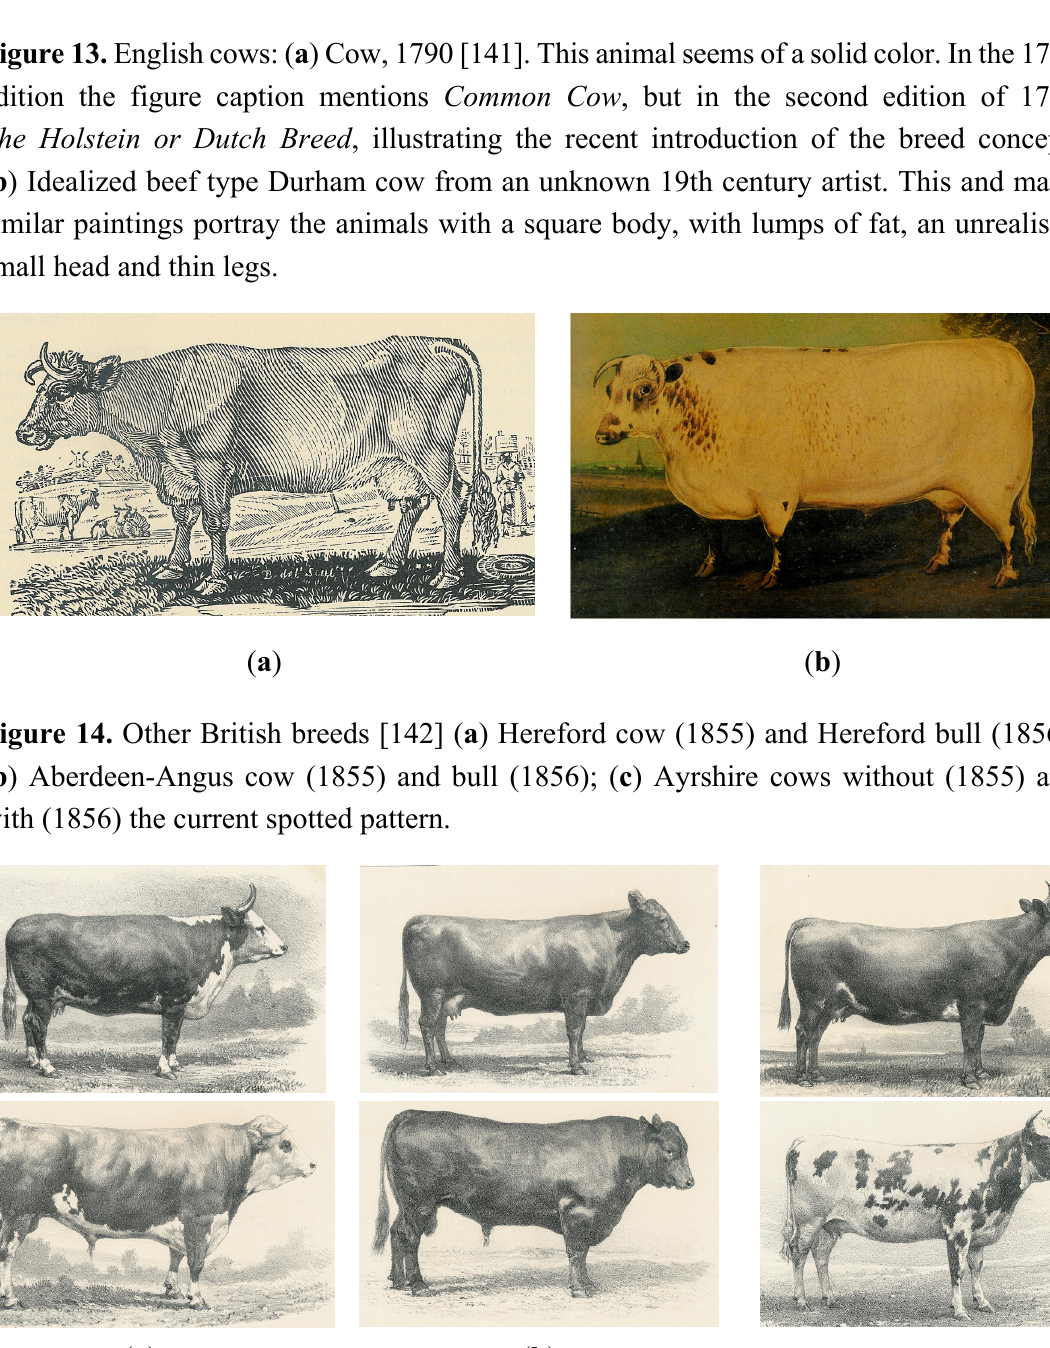
Figure 13. English cows: ( a ) Cow, 1790 [141]. This animal seems of a solid color. In the 1790